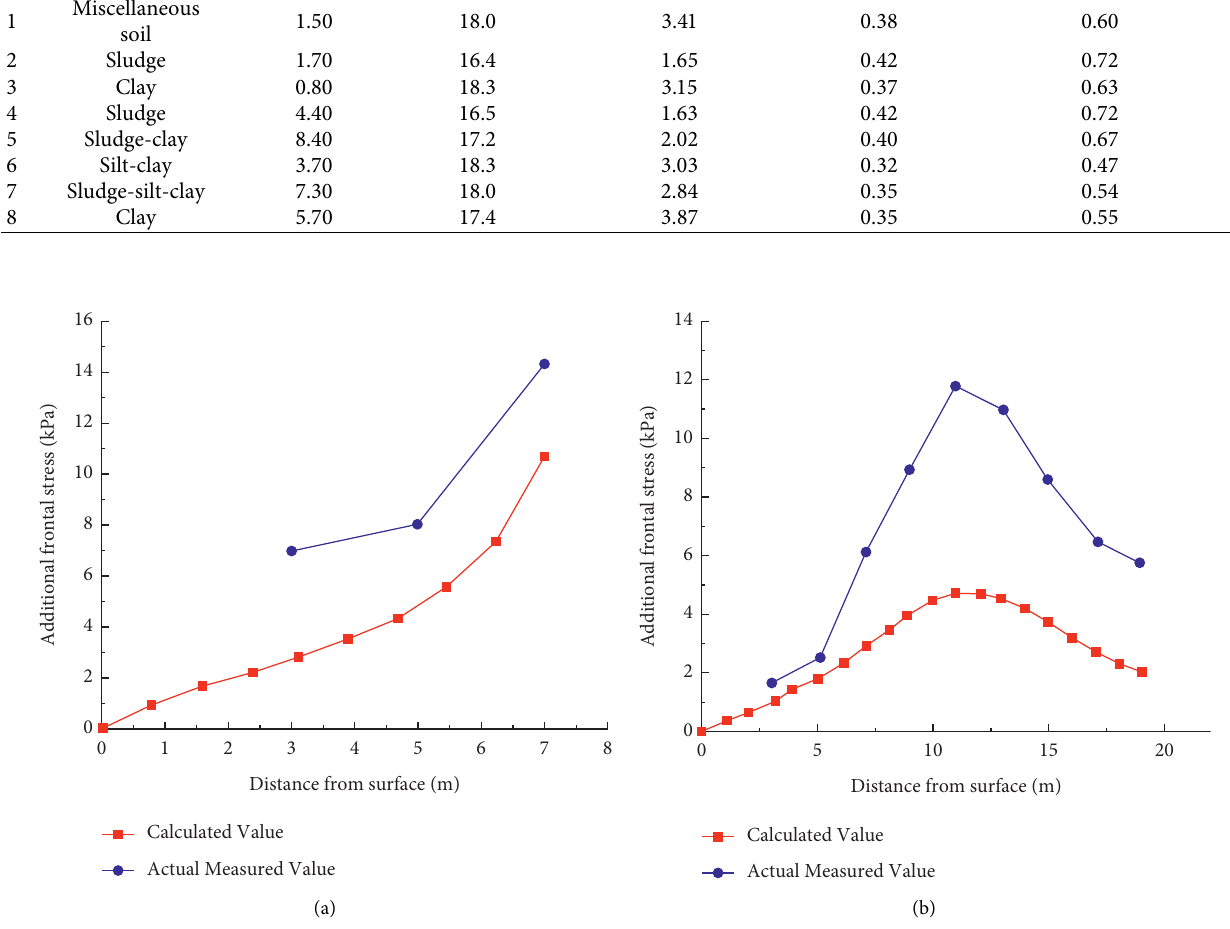
Figure 4: Comparison of calculated and monitoring data of σ